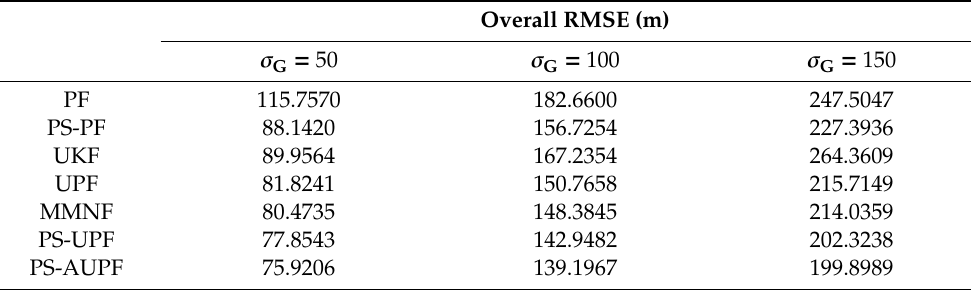
Table 2. Tracking RMSE of each algorithm with Gaussian noise.